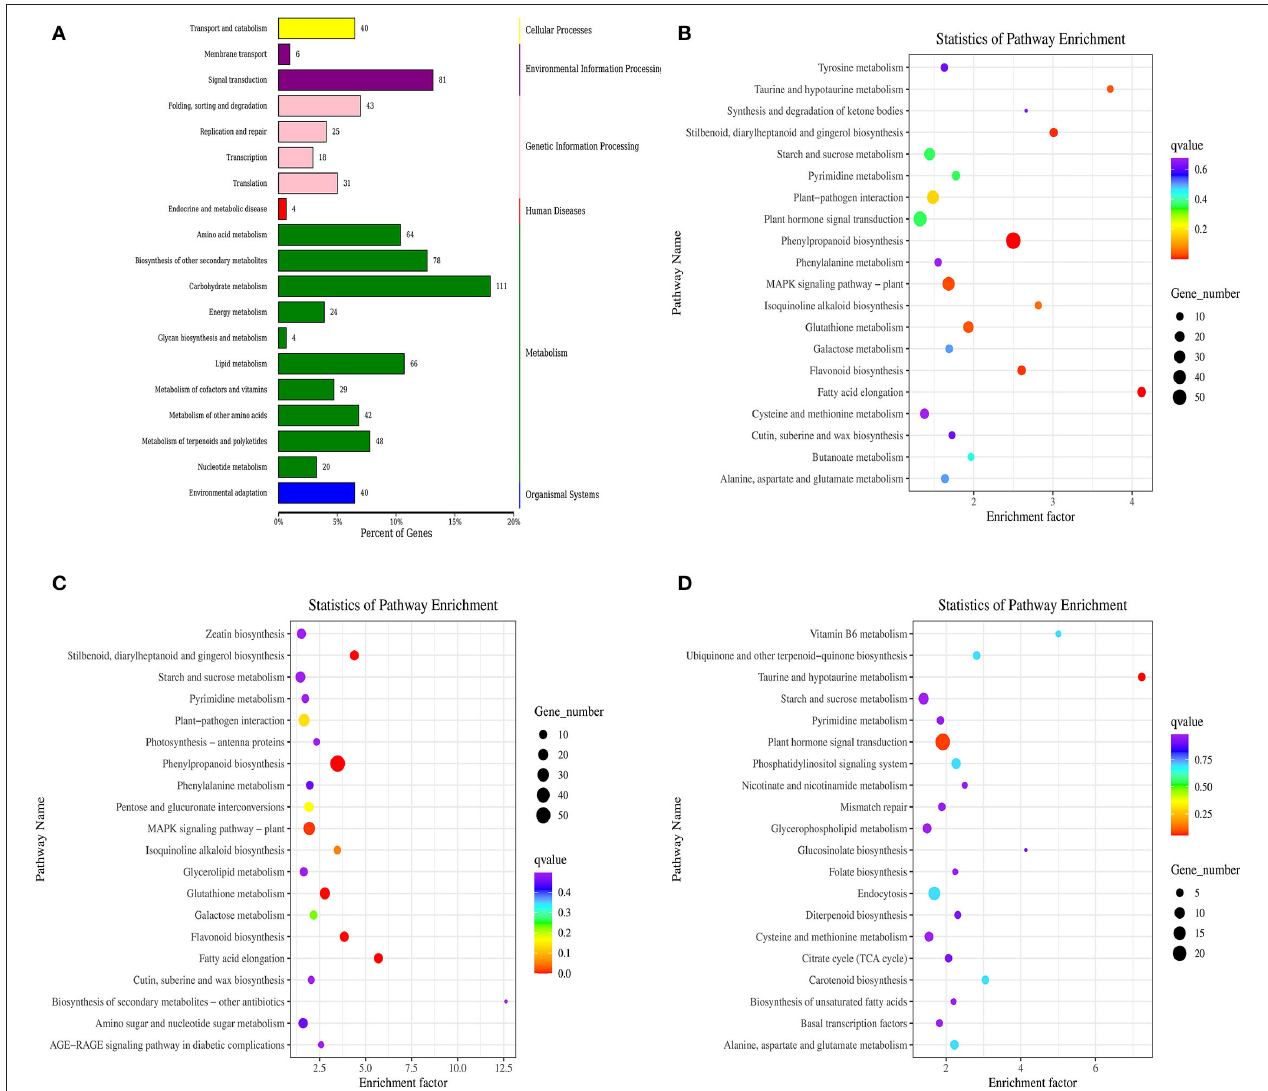
FIGURE 3 | KEGG classification of differentially expressed genes (A) and KEGG pathway enrichment scatter of differentially expressed (B) , up-regulated gene (C) , and down-regulated gene (D) .